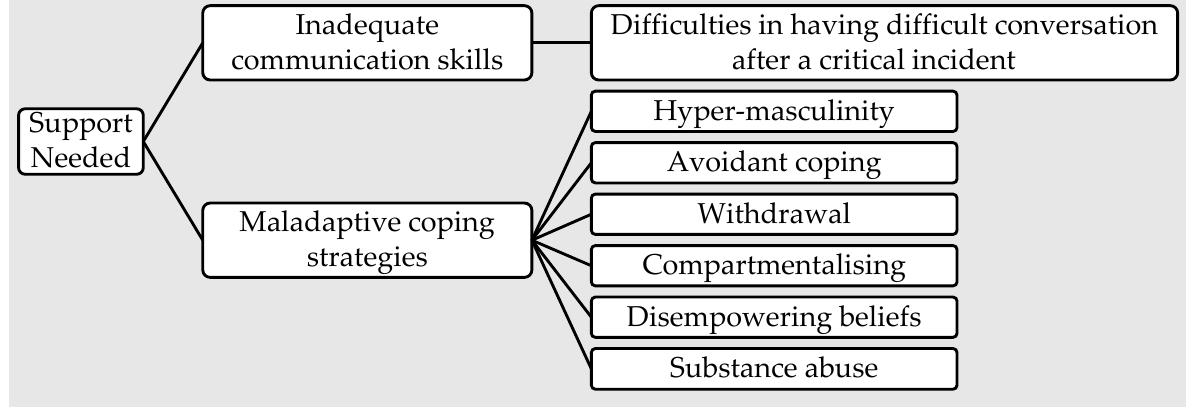
Table 5. Support recommendation .